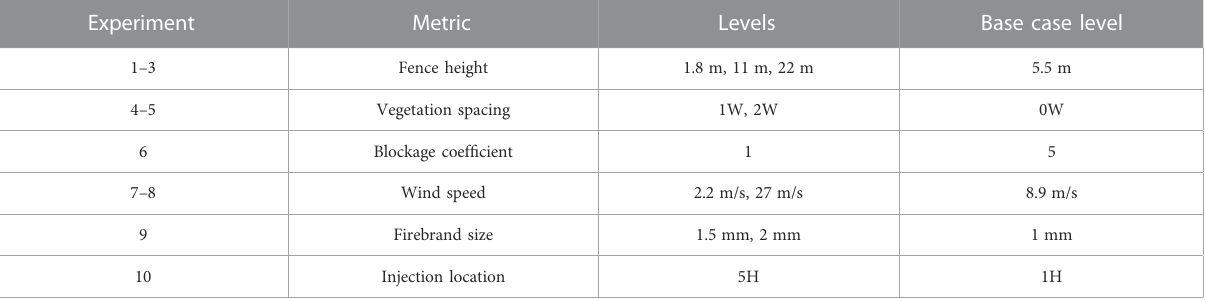
TABLE 1 Exploration of vegetation and fi rebrand metrics. H: height of the vegetation fence in the base case (5.5 m); W: width of an individual tree in the base case (5.5